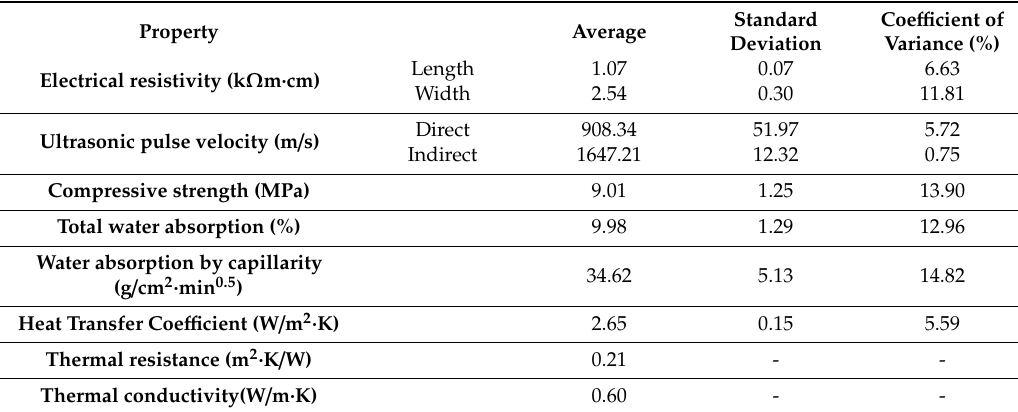
Table 2. Thermophysical proprieties of the analysed compressed earth blocks.